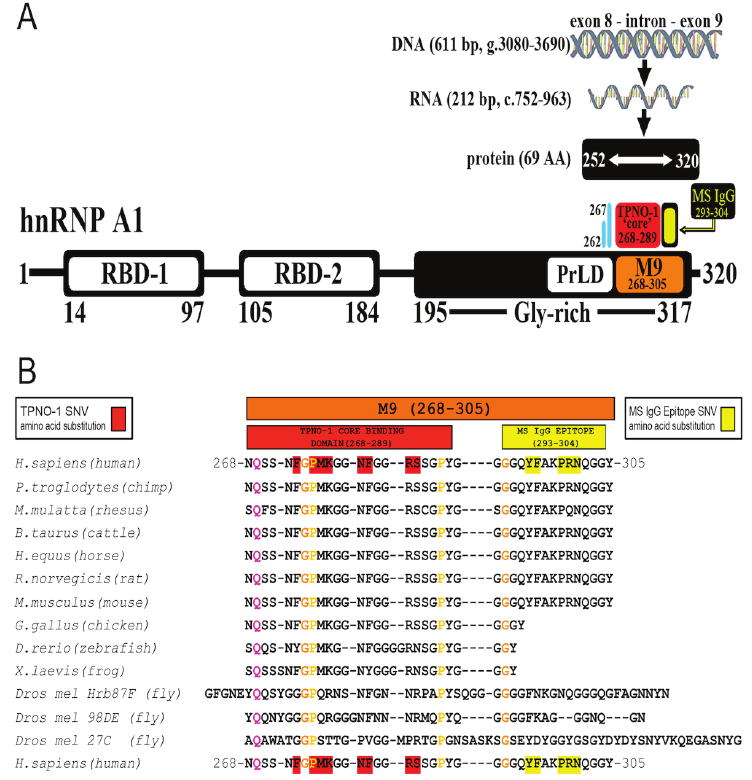
Figure 1. Functional domains and sequence alignment of hnRNP A1. A : Domain schematic of hnRNP A1. The sequence shown is isoform A (NP_002127). Isoform B contains a 52 amino acid insert following AA 251 , resulting in a 372 amino acid protein (not shown). The RNA binding domains (RBD 1 and 2) are contained within the N-terminal half of hnRNP A1. The prion-like domain (PrLD, AA 233-267 ), M9 (AA 268-305 ) and the C-terminus (AA 306-320 ) are shown. M9 (orange) contains the ‘core’ transportin-1 binding domain (TPNO-1, AA 268-289 , red) and the MS IgG epitope (AA 293-304 , yellow). Some literature indicates that the PrLD and TPNO-1 binding domain may overlap, such that the PrLD region includes AA 233-272 and the TPNO-1 binding domain includes AA 263-289 , with the a resulting overlap of AA 263-272 (Supplement 2). The amplicon included DNA from exons 8 and 9 with the intervening intron. The expressed protein included the PrLD that contained ALS- associated mutations (p.D262V (familial), p.N267S (sporadic)(blue)), as well as M9 and the C-terminus of hnRNP A1. (bp base pair). B : Sequence alignment of hnRNP A1-M9. Human sequences are 100% conserved in mammals, except for M. mulatta (rhesus). There is also high sequence conservation between orthologs (mammals, non-mammalian vertebrates ( G. gallus - chicken, D. rerio - zebrafish, X. laevis - frog) and invertebrates ( D. melanogaster - fruit fly). SNVs resulting in amino acid substitutions in the TPNO-1 core domain are highlighted in red boxes. SNVs resulting in amino acid substitutions in the MS IgG epitope are highlighted in yellow boxes. Colored amino acids are present for clarity identifying conserved sequences through all species. Black lines (gaps) are inserted between residues so that similar or identical amino acids are aligned in each column.